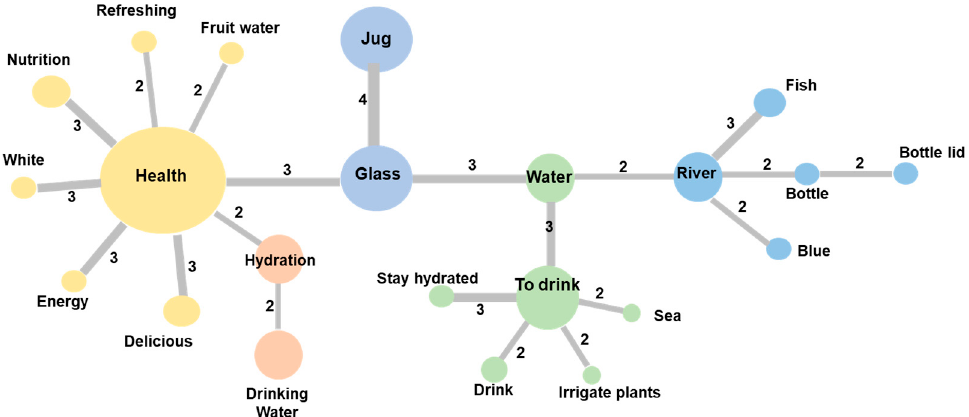
Figure 1. Graphic representation of the similarities of the words related to the social representation of “drinking water”, in schoolchildren from Zapopan, Mexico ( n = 50). The words presented in the figure are those mentioned concurrently among the participants. The size of the sphere is proportional to the number of times the word was mentioned (the larger the number, the greater the co-occurrence). The number makes reference to the number of times the term was mentioned, while the colors represent groups of semantic proximity.